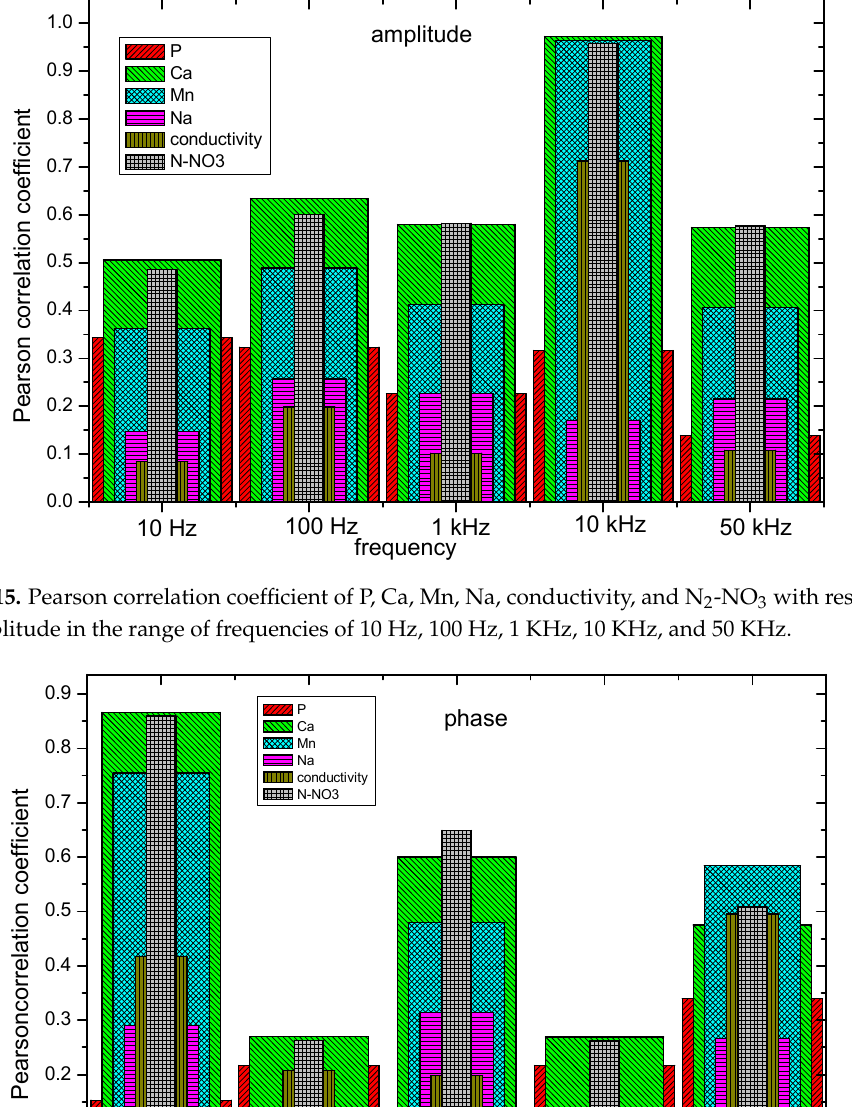
Figure 14. Phase frequency response as a function of the temperature for eight samples.